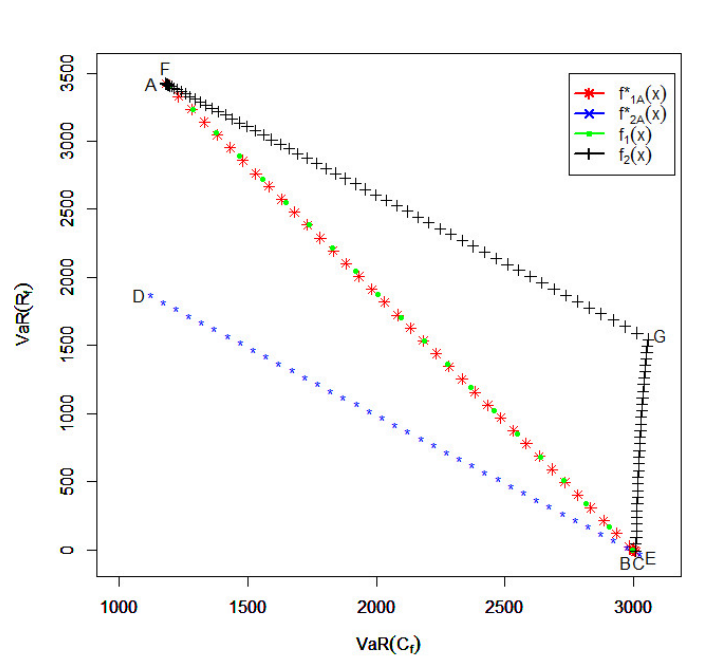
Figure 5. VaRs of the cedent and the reinsurer under different policies: Scenario